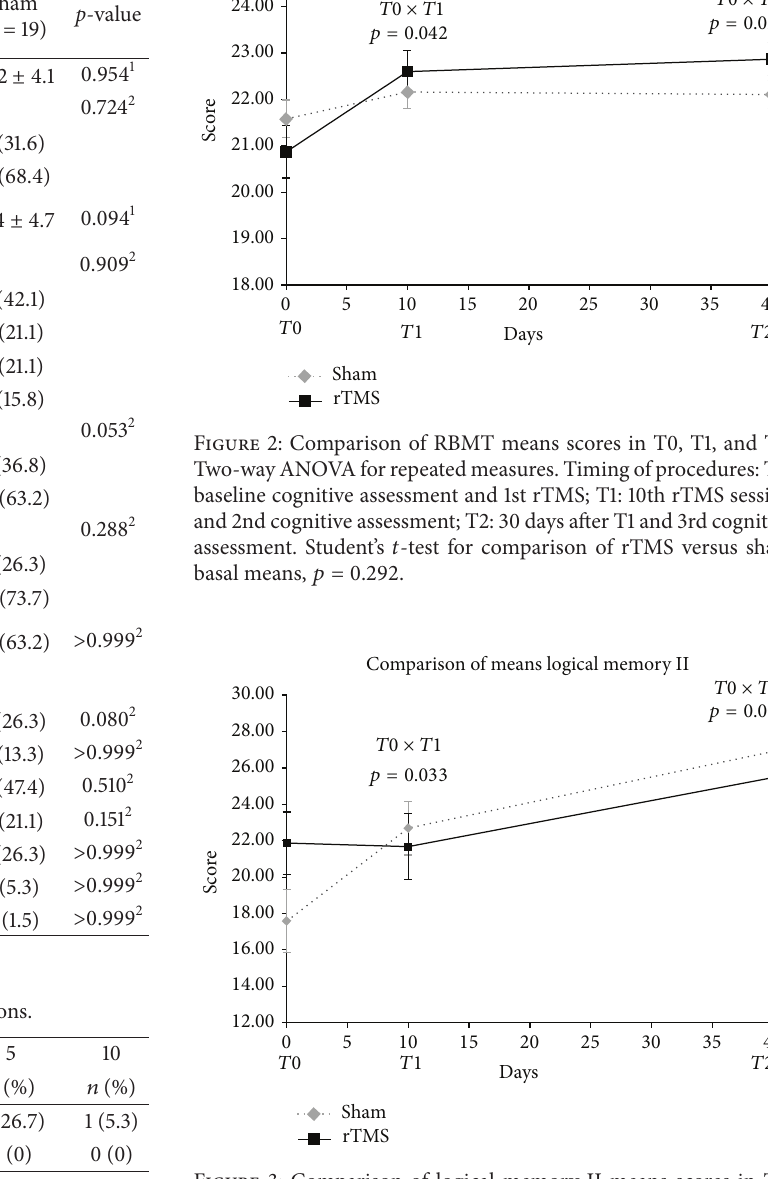
Figure 3: Comparison of logical memory II means scores in T0, T1, and T2. Two-way ANOVA for repeated measures. Timing of procedures: T0: baseline cognitive assessment and 1st rTMS; T1: 10th rTMS session and 2nd cognitive assessment; T2: 30 days after T1